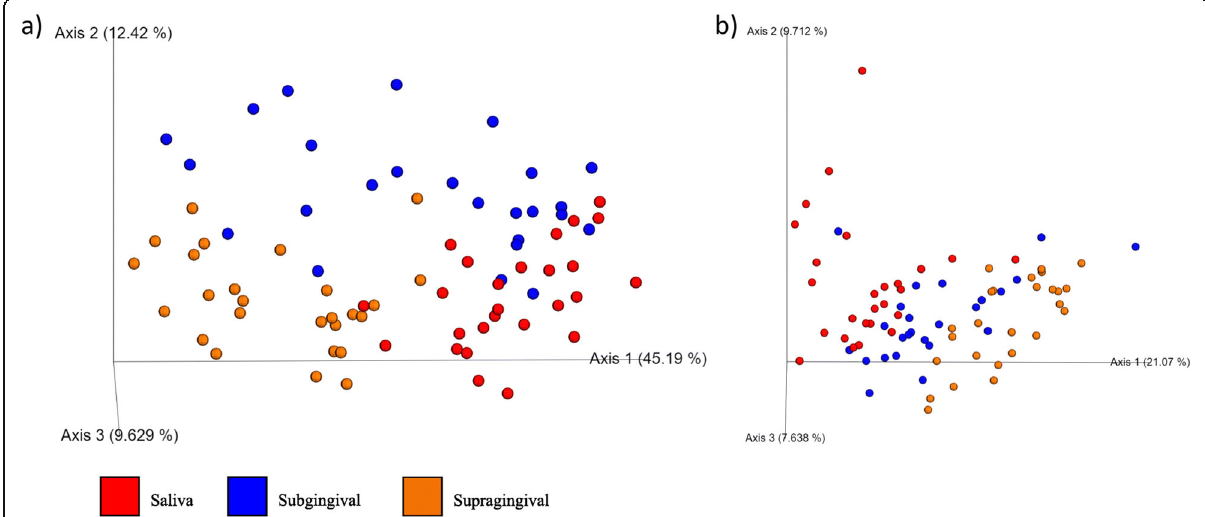
Fig. 2 Principal coordinates analysis (PCoA) plots of weighted ( a ) and unweighted ( b ) UniFrac distances of oral microbial communities performed on the 97% OTU abundance matrix using